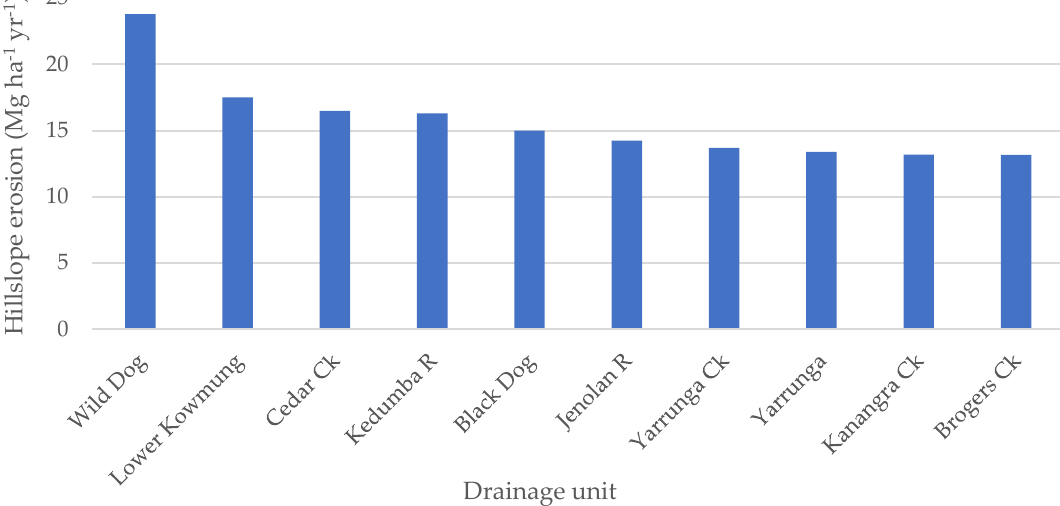
Figure 7. The highest erosion risk drainage units within the Sydney drinking water catchment area